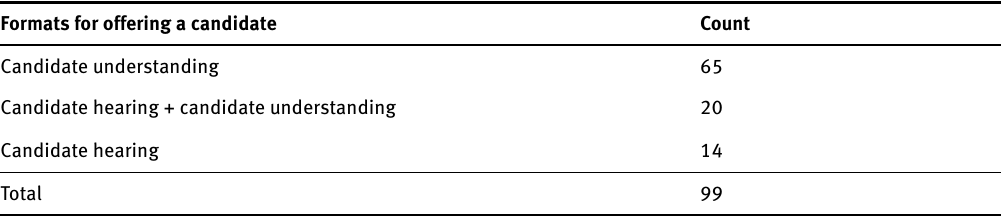
Table 6: Different types of restricted offer type repair initiators Formats for offering a candidate Candidate